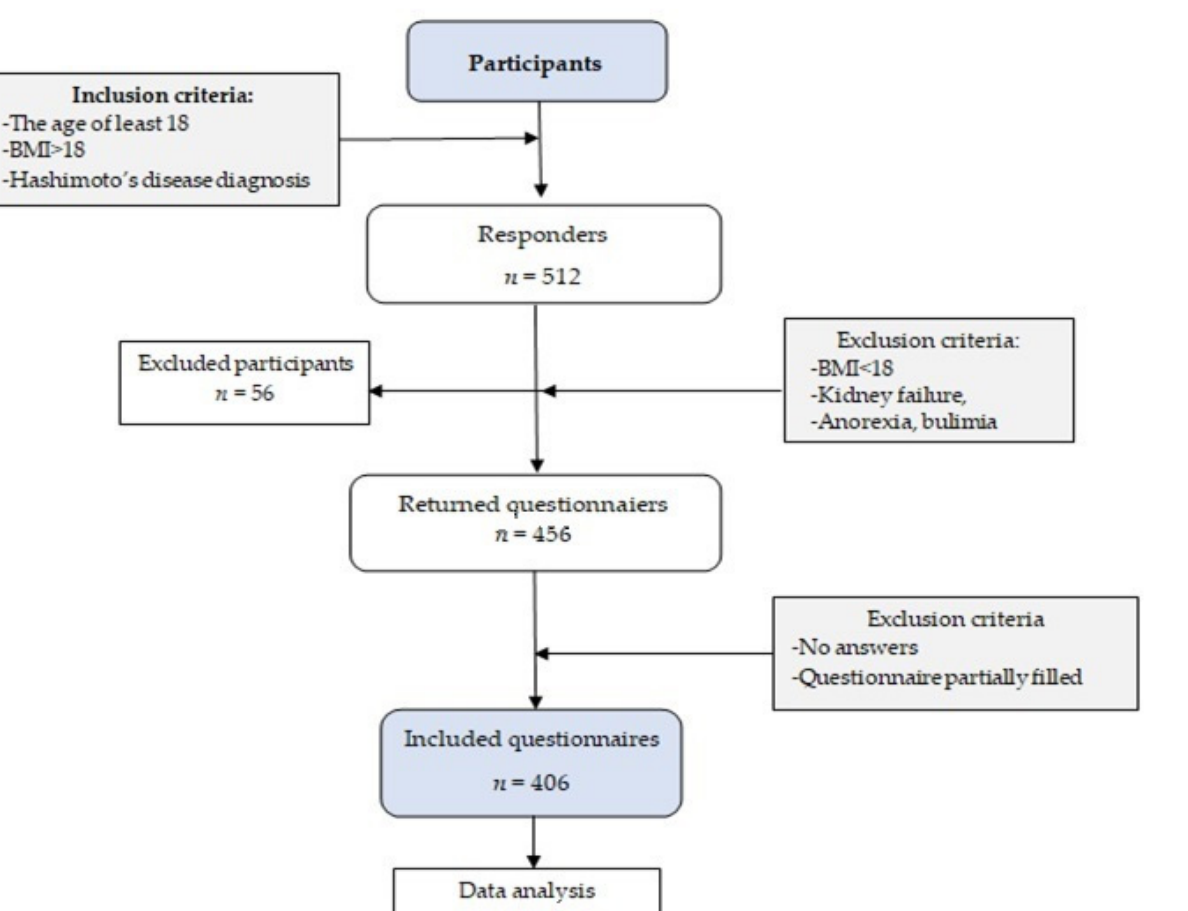
Figure 1. Flowchart: study design and data collection ( n —number of participants).